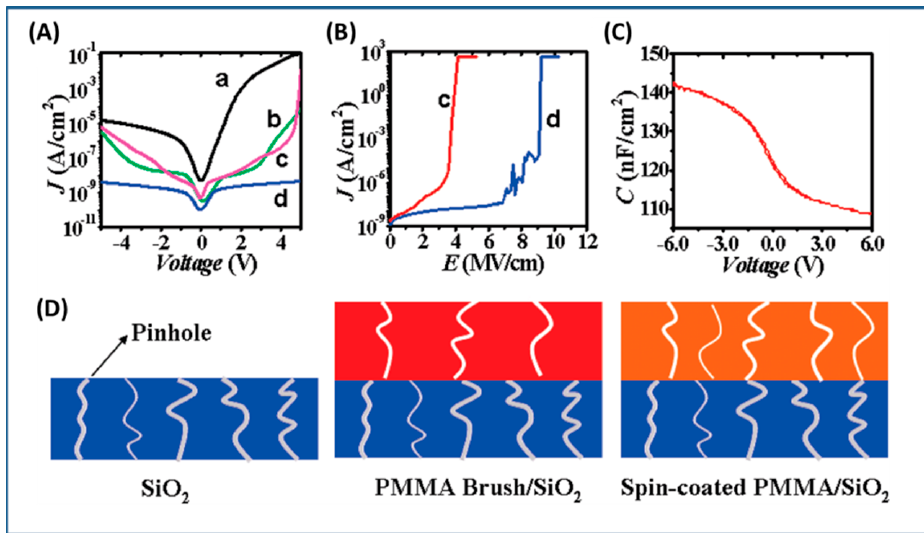
Figure 4. ( A ) Leakage characteristics and ( B ) breakdown electric field characteristics for different dielectrics measured with the structure of Au/dielectric/Si capacitor. Curve a, SiO 2 (9 nm); curve b, spin-coated PMMA (10 nm)/SiO 2 (9 nm); curve c, surface-grafting PMMA (20 nm); curve d, surface-grafting PMMA (10 nm)/SiO 2 (9 nm). ( C ) Capacitance-voltage characteristics for PMMA/SiO 2 dielectrics. C - V curves were measured at an ac signal frequency of 1 MHz. ( D ) Schematic diagram of distribution of pinhole defect in the dielectrics, indicating the reason why PMMA brush/SiO 2 bilayer dielectrics show the lowest the leakage compared bare SiO 2 and spin coated PMMA/SiO 2 dielectrics. Reproduced with permission from Ref [101].